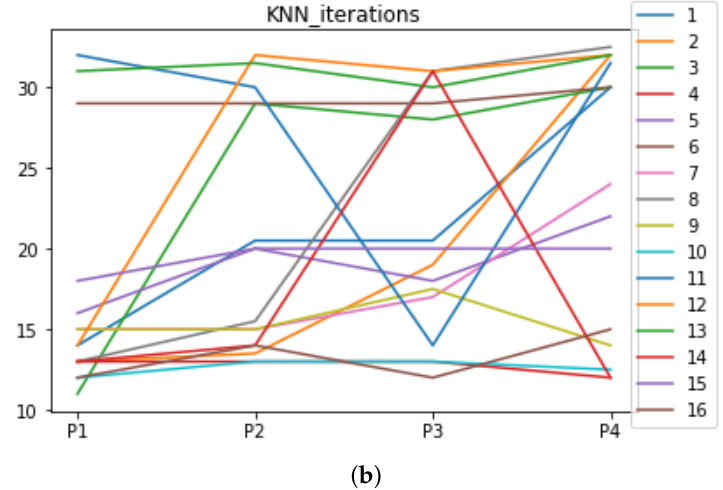
Figure A6. Number of iterations per partition. Each line represents a dataset (medians). ( a ) Number of iterations DT. ( b ) Number of iterations KNN.